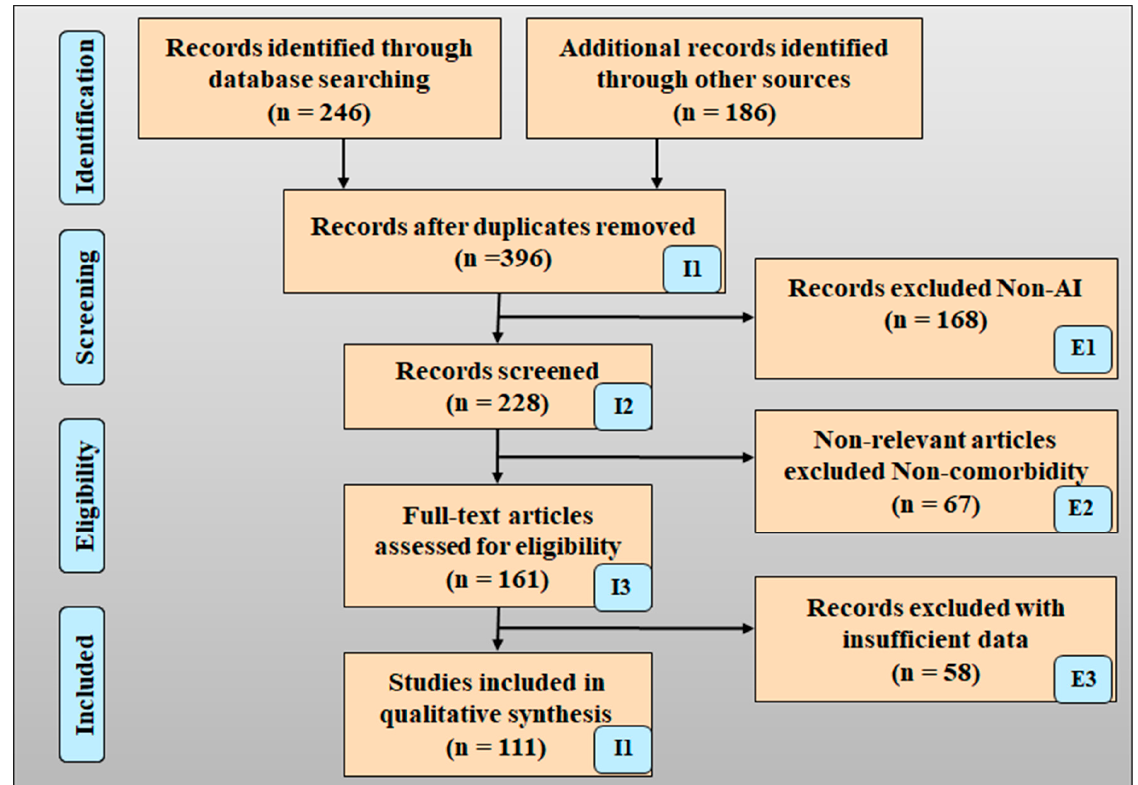
Figure 2. PRISMA model for early detection of the PD by using AI.